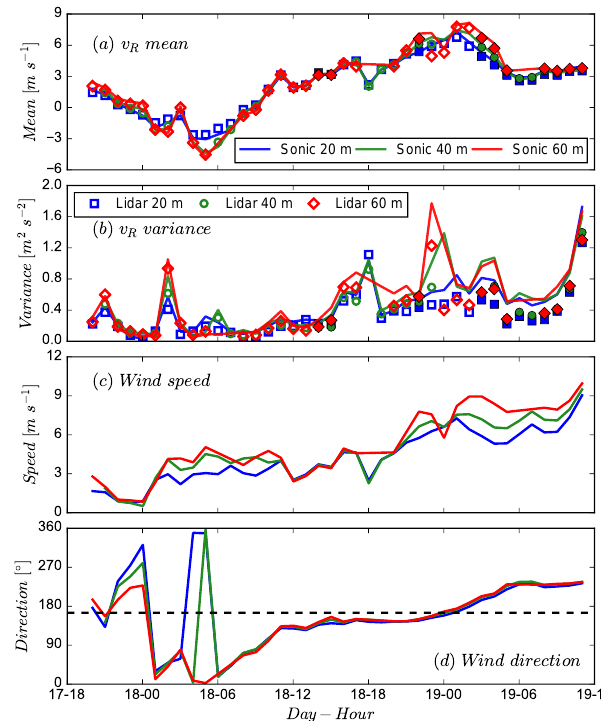
Figure 5. Time series of (a) hourly mean and (b) variance of radial velocity ( v R ) from the lidar (markers) and the sonic anemometers (lines) and time series of (c) hourly mean wind speed and (d) di- rection from the sonic anemometers at three different heights. The mean and variance of radial velocity from the hourly time series classified as stationary using the method of Foken and Wichura (1996) are shown by the filled markers. The dashed line in (d) gives the wind direction under which the sonic anemometers are in the center of the wind turbine